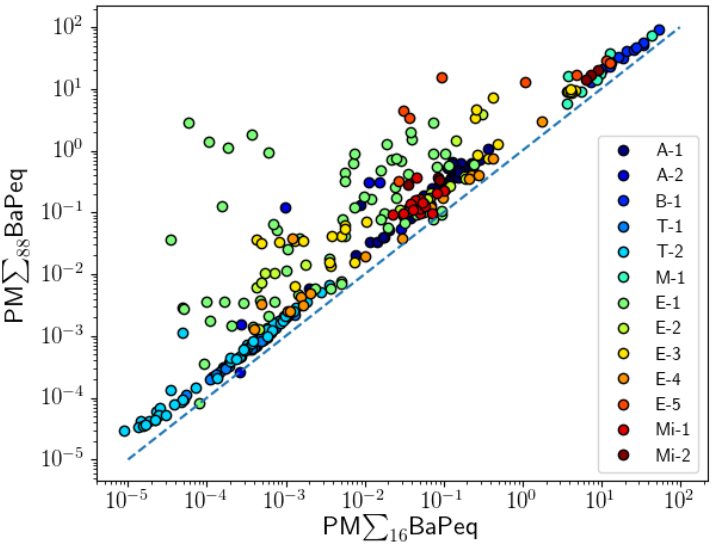
Figure 2 . Correlation between BaPeq of 88 PAHs in particle-phase (PM) and 16 EPA particle-phase PAHs analyzed for 13 projects (Table 1). Table 2 . BaPeq correlations of 16 EPA priority particle-phase PAHs (PM∑ 16 BaPeq) with a BaPeq of 88 particle-phase PAHs (PM∑88BaPeq) and BaPeq of both particle- and gas-phase PAHs. The calculations were performed using Spearman’s correlation.